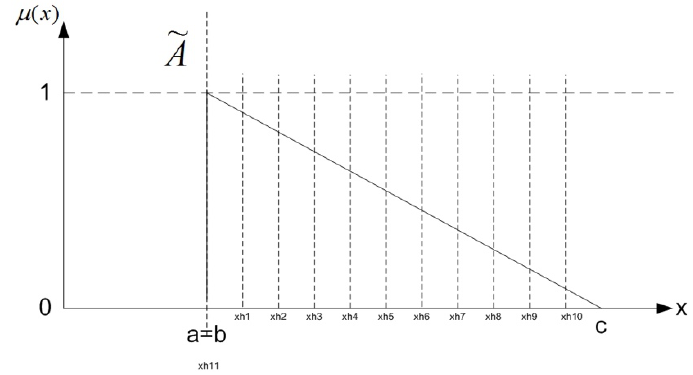
Fig. 4. Triangular fuzzy number with a vertical side (𝑎 = 𝑏 , 𝑏 < 𝑐) .